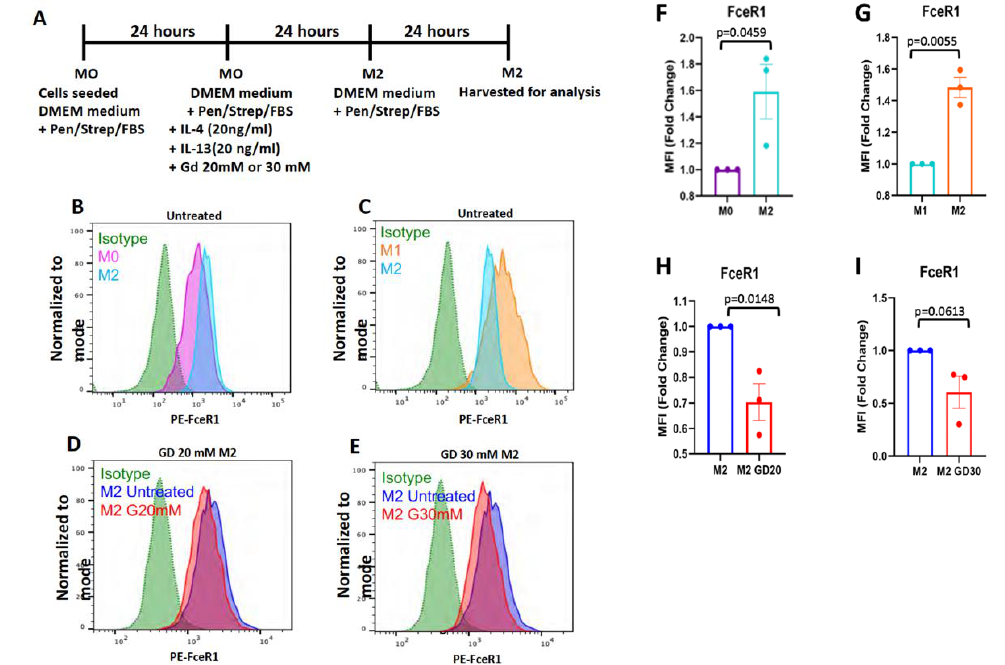
Figure 15. Dotarem downregulated the expression of the anti-inflammatory M2 marker FceR1. ( A ) The scheme and timeline of M2 polarization and Dotarem (gadolinium, Gd) treatment. ( B – E ) Flow cytometry analysis indicated that the high expression of FceR1 was characteristic for M2 macrophages and that gadolinium treatment decreased FceR1 expression. ( F – I ) Graphs from the flow cytometry data showed that the upregulation of FceR1 expression in M2 macrophages and its downregulation upon Dotarem treatment were statistically significant.